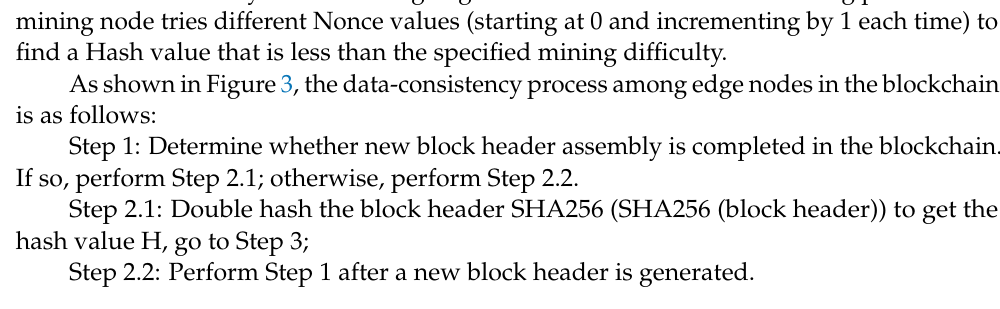
Figure 2. Data-privacy security framework for the industrial Internet of Things based on block- chain.